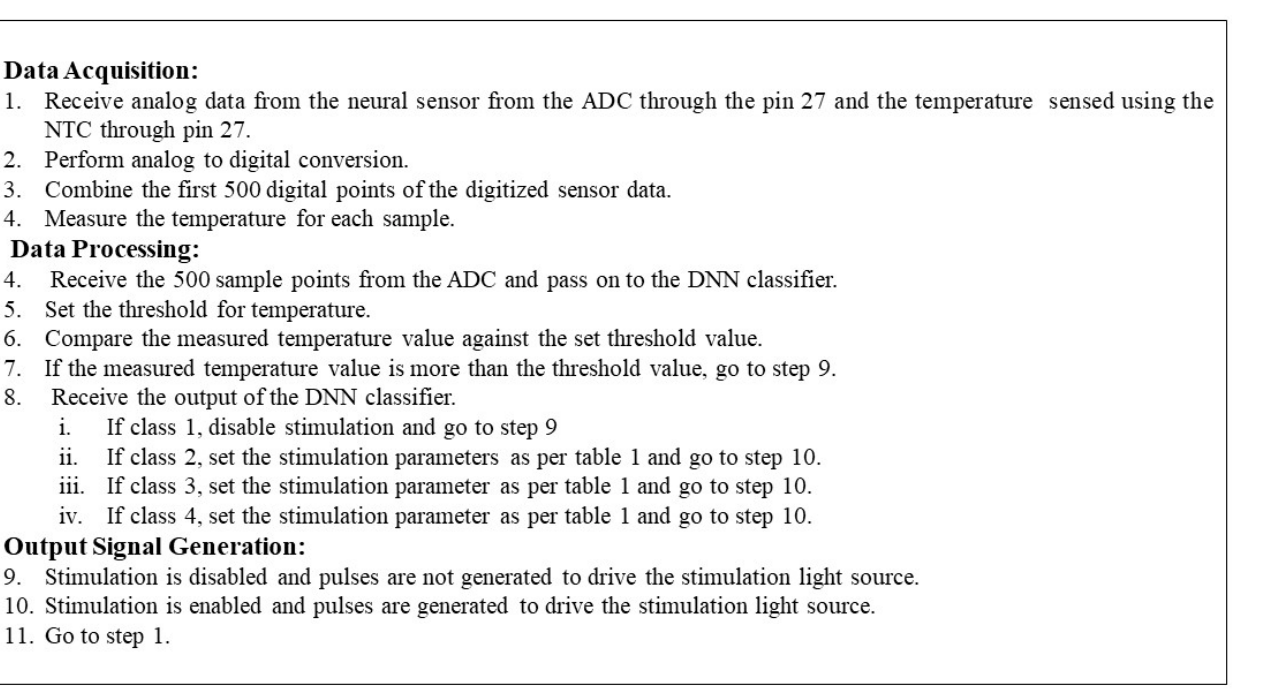
Figure 5. Pseudo-code for the software component.